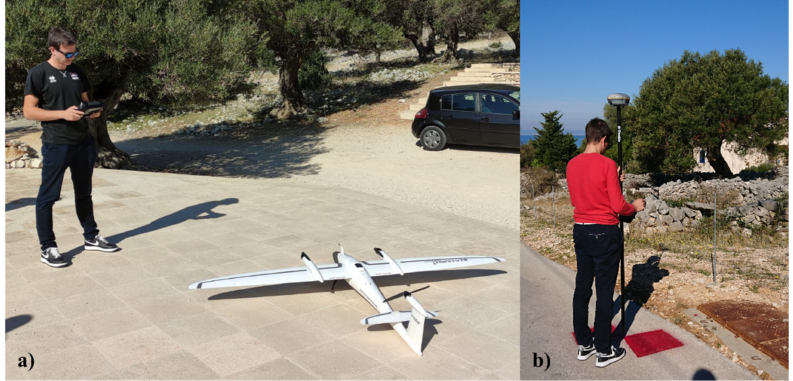
Figure 3. Field work; ( a ) Trinity F90+ MS mission; ( b ) Trimble R8s CPs and RP